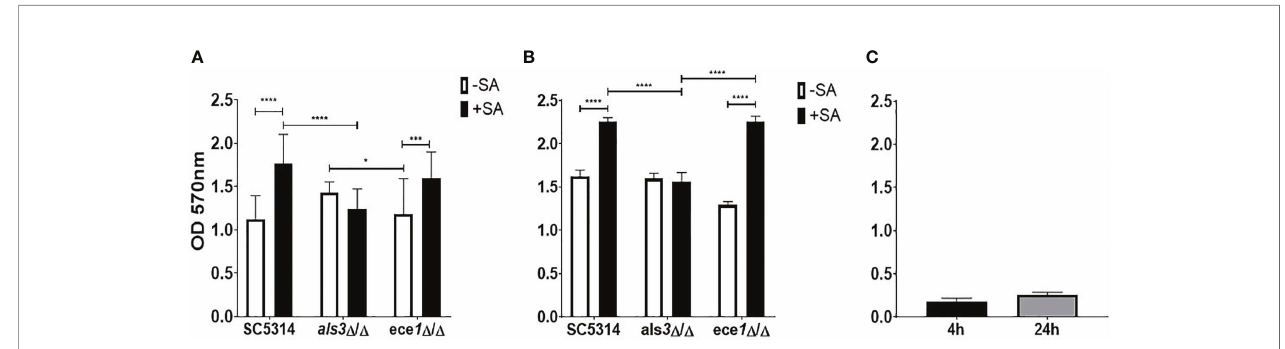
FIGURE 1 | Als3 is responsible for Candida-Staphylococcus interactions. Single and multi-species bio fi lms containing C. albicans and S. aureus were grown for (A) 4 h and (B) 24 h; (C) single species S. aureus bio fi lm only. Biomass was quanti fi ed by staining using 0.05% crystal violet. Experiments were performed on three separate occasions and error bars represent standard deviation of the mean (*; P < 0.05, ***; P < 0.001, ****; P <